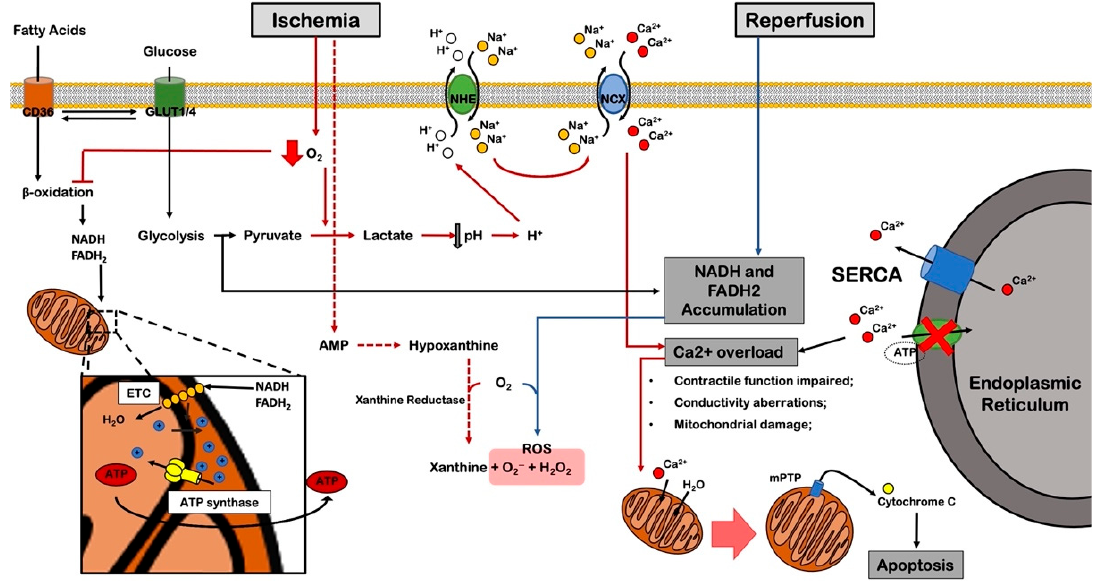
Figure 3. Schematic representation of molecular pathways regulating cell metabolism during myocardial ischemia. Ischemic injury leads to metabolic derangements, which converge to mitochondrial dysfunction and contractile dysfunction. AMP/ATP, adenosine mono/tri-phosphate; ETC, electron transport chain; FADH2, (reduced) flavin adenine dinucleotide; GLUT, glucose transporter; mPTP, mitochondrial permeability transition pore; NADH, (reduced) nicotinamide adenine dinucleotide; SERCA, sarco-endoplasmic reticulum calcium